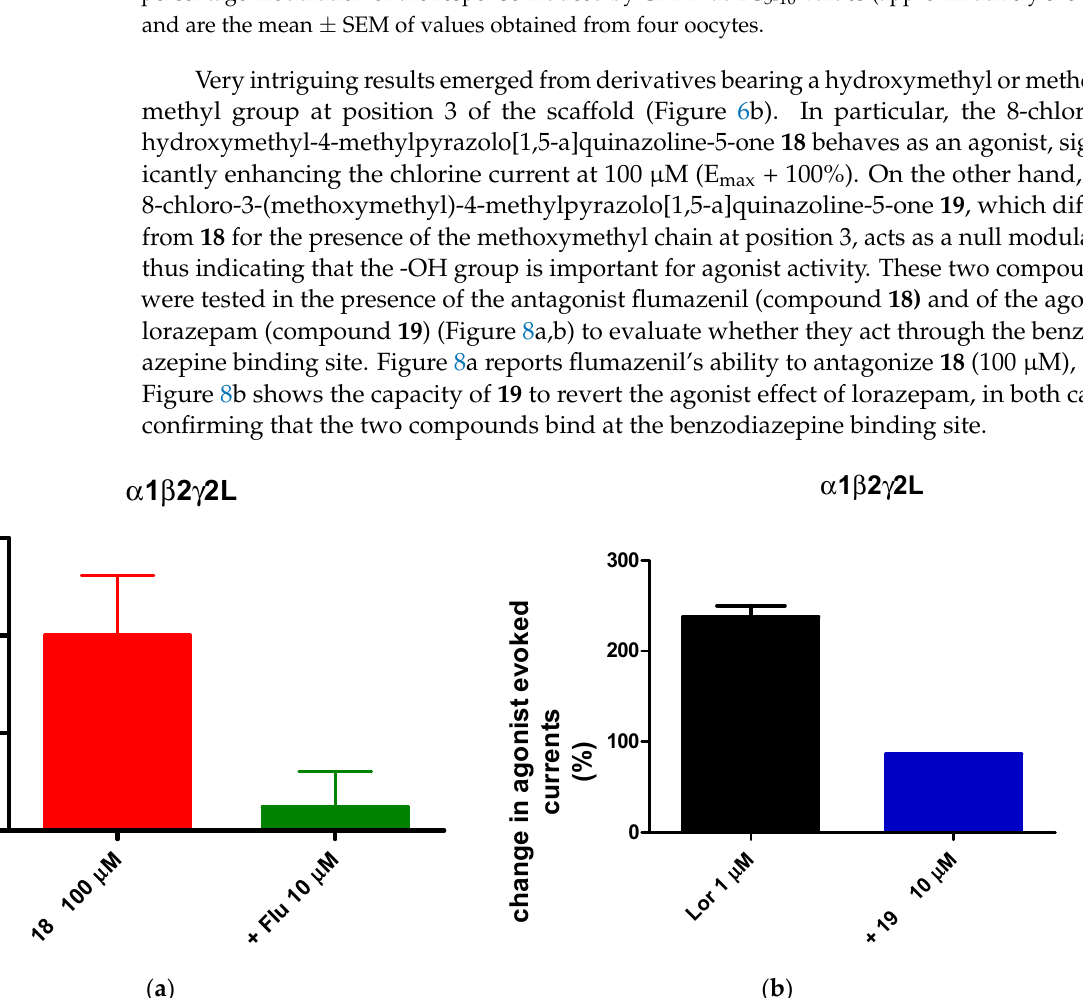
Figure 7. Compound 3 antagonized the potentiation of GABA-induced Cl − currents by lorazepam in Xenopus laevis oocytes expressing recombinant α 1 β 2 γ 2L-GABA A receptors. Data are expressed as the percentage modulation of the response induced by GABA at EC 5-10 values (approximatively 3–5 µ M) and are the mean ± SEM of values obtained from four oocytes.